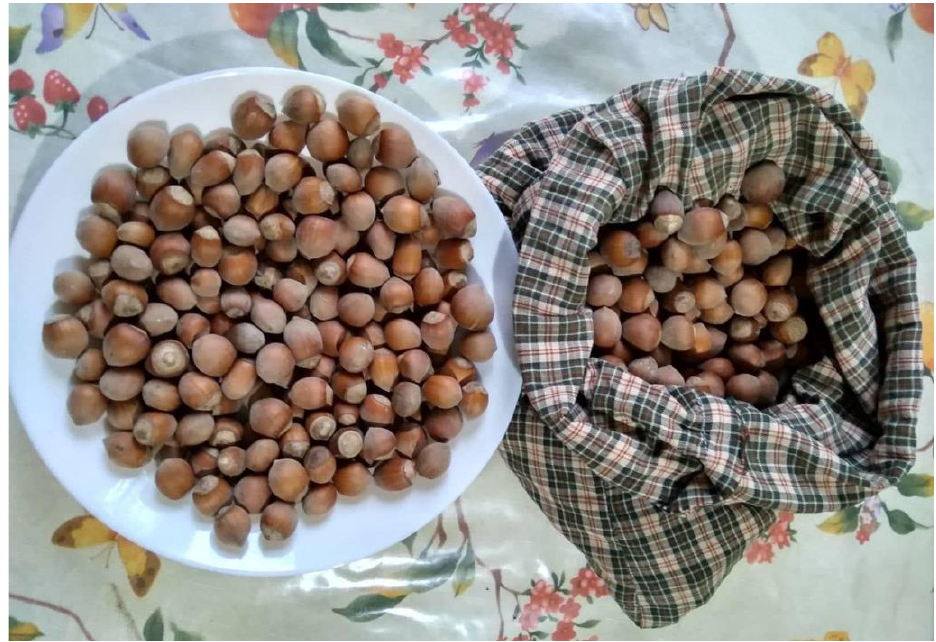
Figure 5. Hazelnut ( Corylus avellana ); (Photo: Stryamets S).